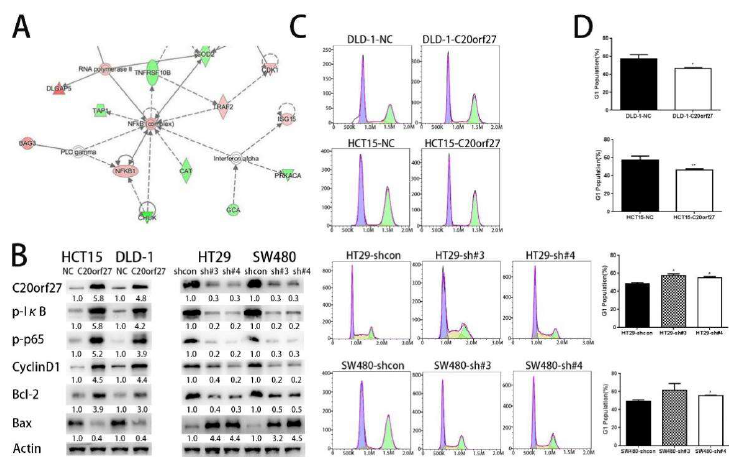
Figure 2. C20orf27 regulates the cell cycle by activating the NFkB pathway. ( A ) IPA analysis of differentially expressed proteins between C20orf27 -overexpressing HCT15 /DLD-1 and HCT15 /DLD-1-NC cells, suggesting the NFĸB pathway being involved; ( B ) Western blot analysis for the expression of p-IĸB, p-p65, CyclinD1, Bax, and Bcl-2 in C20orf27 overexpressing and knockdown cells; ( C ) Flow cytometric analysis for the G1 phase of cells with C20orf27 overexpression and silencing. * p < 0.05, ** p < 0.01.